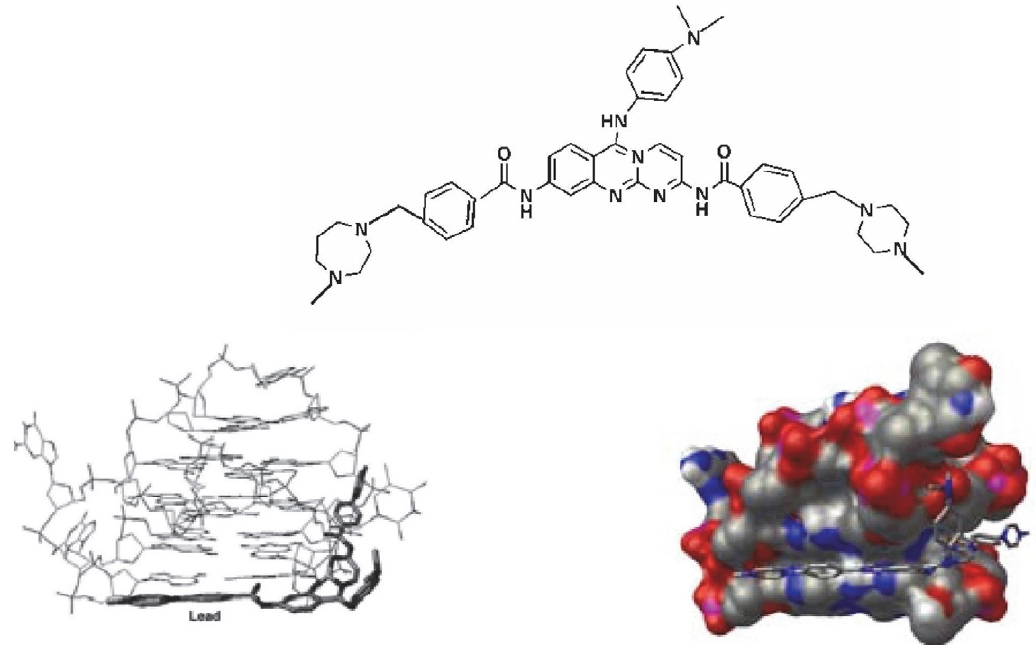
Figure 7. Proposal of lead candidate structure to interact with the c-Myc promoter G4 through external stacking and groove binding simultane- ously. This proposal was based on HTVS experiments employing the key pharmacophore features of BRACO-19 for the search of the KEGG da- tabases.